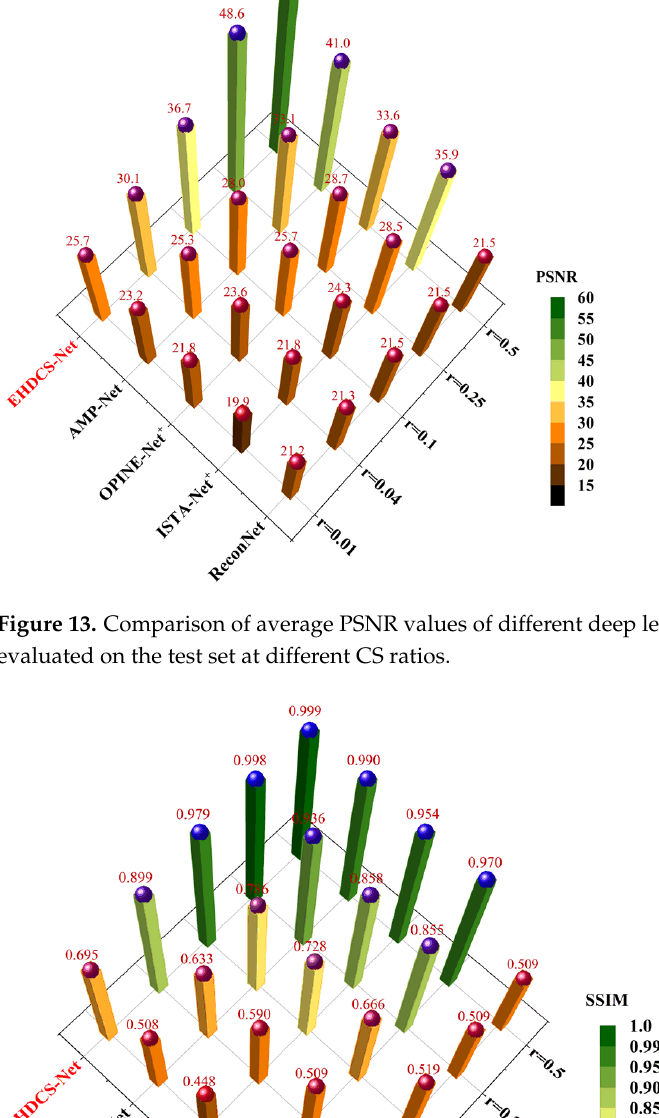
Figure 12. Visual quality comparison of large-scene construction site monitoring image CS recov- ery of different deep learning-based image CS methods in the case of CS ratio = 0.1.